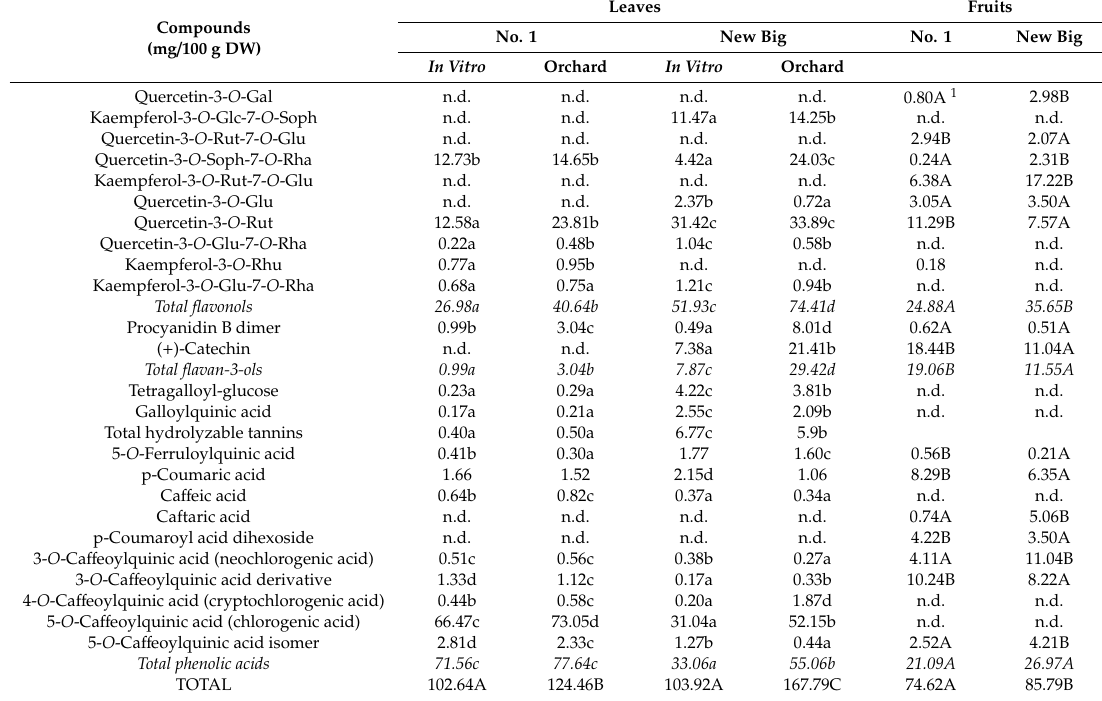
Table 4. Content of polyphenolic compounds in leaves and fruit of two cultivars of L. chinensis . Leaves Fruits Compounds No. 1 New Big No. 1 New Big (mg / 100 g DW) In Vitro Orchard In